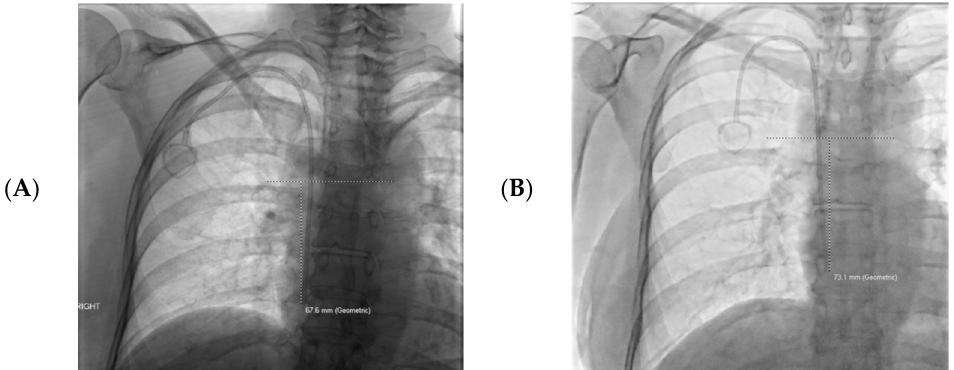
Figure 1. An example of catheter tip measurements obtained at the time of placement ( A ) and at the time of catheter removal ( B ). A line was made perpendicular to the carina to allow accurate measurement of the catheter tip distance from the carina. In this case the catheter advanced 3.7 cm caudally, and was recorded as − 3.7 cm when calculating the data (positive numbers migrated cranially towards or beyond the carina).